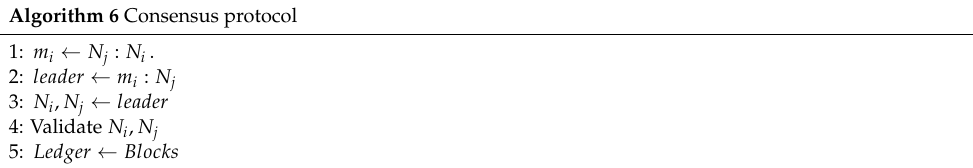
Algorithm 6 Consensus protocol